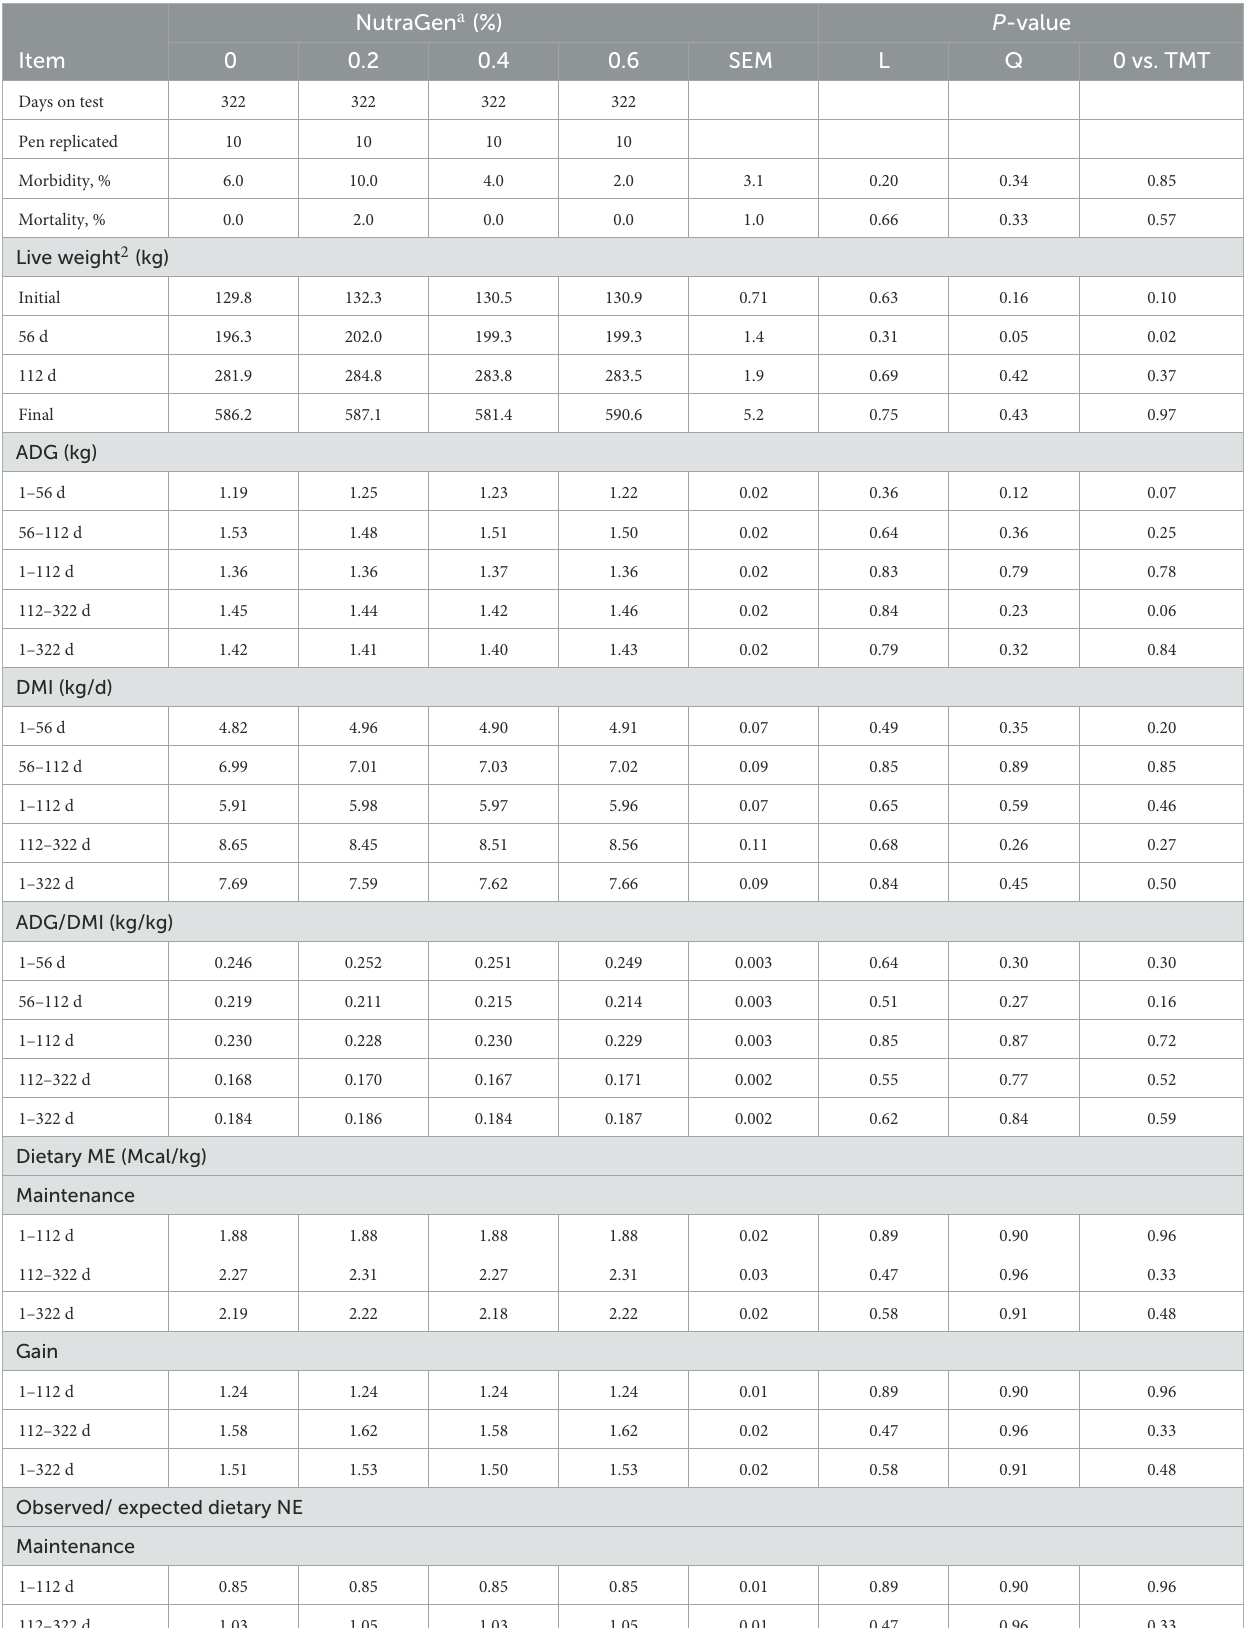
TABLE 2 Effects of feeding NutraGen supplement on health, growth performance and dietary net energy